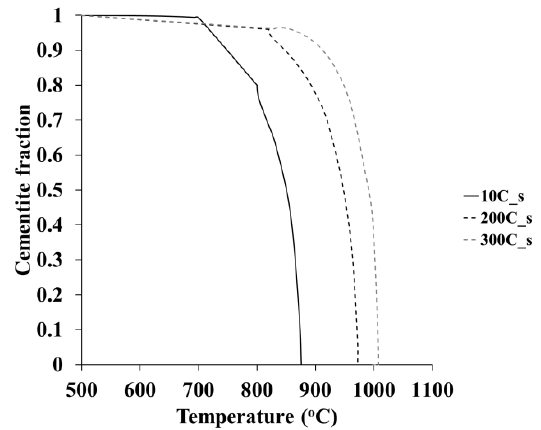
Figure 7. Diminution of cementite size related to heating rate and temperature.